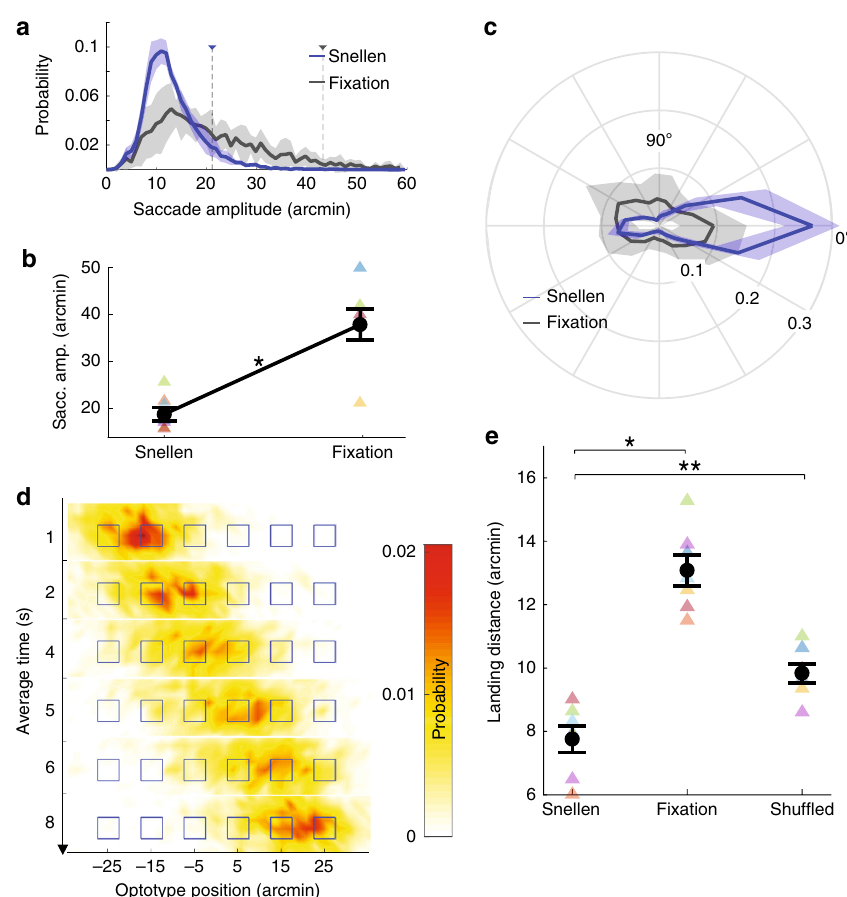
Fig. 3 Microsaccade characteristics. a Average distribution of microsaccade amplitudes. Oculomotor data collected in the Snellen test (blue) are compared to those measured during sustained fi xation (gray). Dashed lines indicate the means of the distributions. b 90th percentiles of the amplitude distributions in the two conditions ( * p = 0.0009; two-tailed paired t -test). c Average distributions of microsaccade directions. d Distributions of gaze probability at different times during the course of the trial. The squares mark the optotypes positions. Note the left-to-right gaze shift mediated by microsaccades. e Average distance between microsaccade landing and the nearest optotype. Data from the Snellen test are compared to those obtained when microsaccades in Snellen were randomly replaced by those executed during fi xation (Fixation) or when they were randomly permutated (Shuf fl ed; * p = 0.00008, ** p = 0.0009; two-tailed paired t -test). Shaded regions and error bars represent SEM. Triangles in b and e represent data from individual subjects. Source data are provided as a source data fi